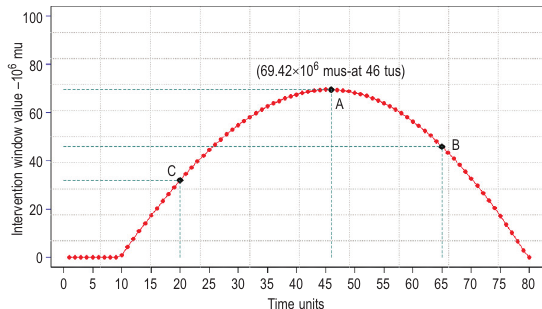
Fig. 2. Values of intervention